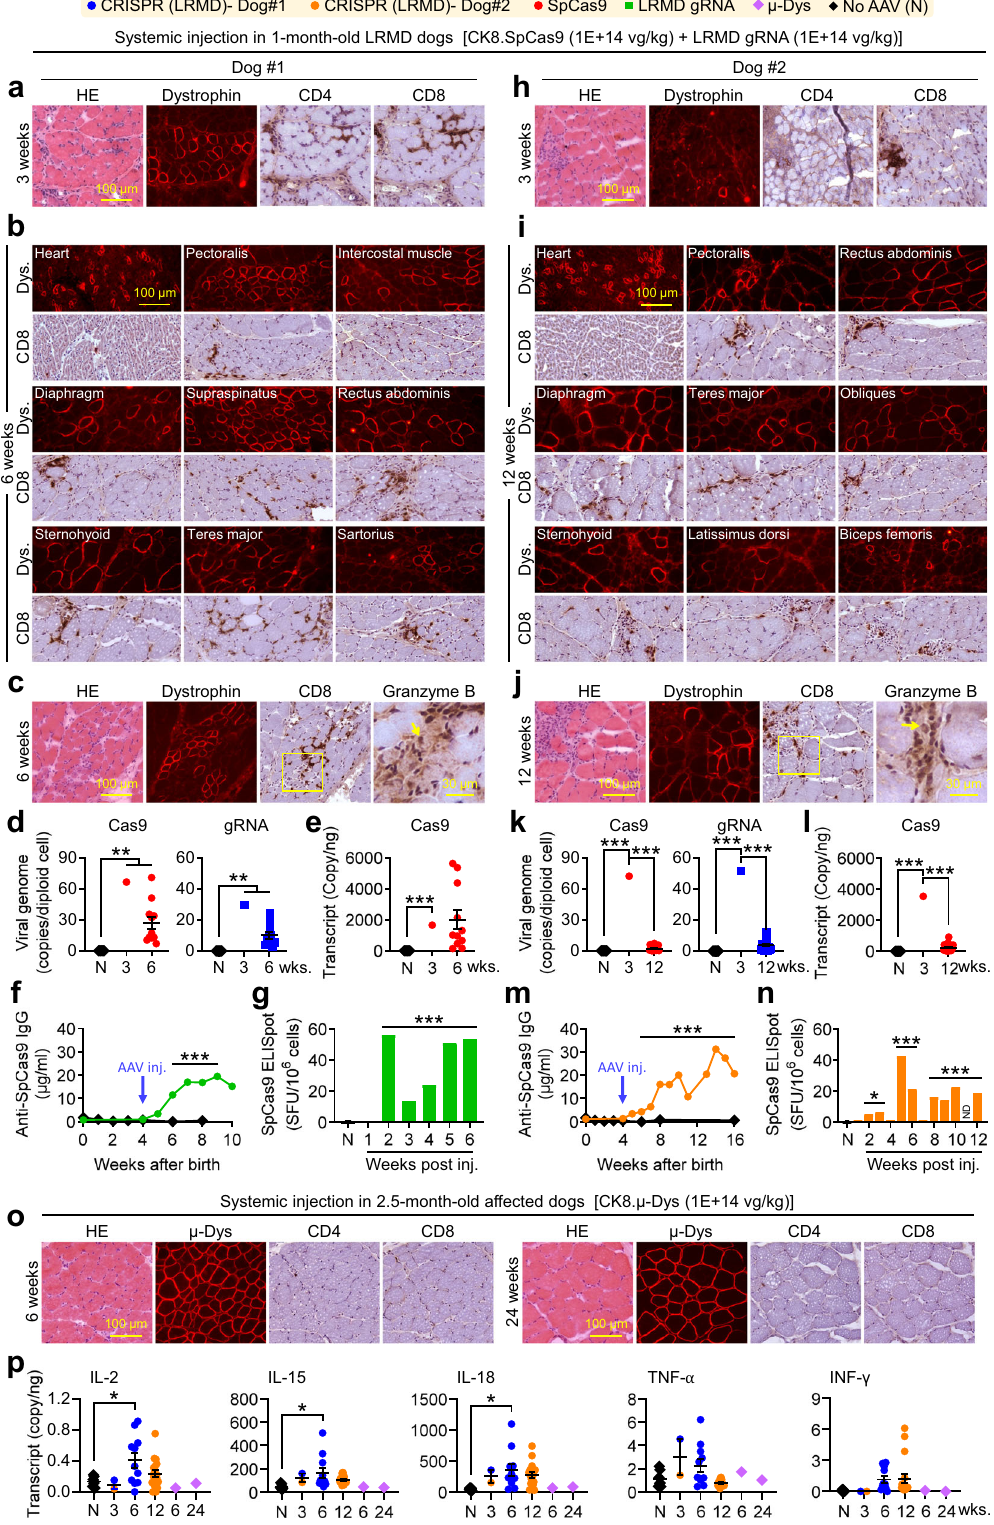
detection of the Cas9 protein by western blot. The AP cis-plasmid (pcisRSV.AP) was published previously 45 . All cis-plasmids were con fi rmed by sequencing. AAV production and puri fi cation . The stock AAV8 and AAV9 vectors were produced using our previously reported triple plasmid transfection protocol using 293 cells 46,47 . AAV was puri fi ed through three rounds of isopycnic CsCl